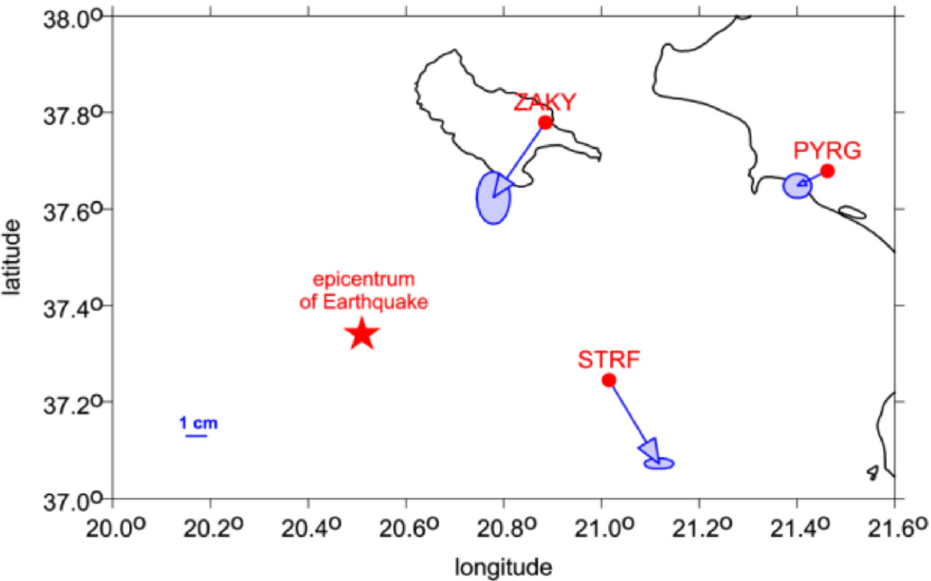
Figure 4. Geographical distribution of stations PYRG, STRF, and ZAKY, associated with a vector of horizontal shift and 2.95 sigma errors (RMSE 2nd approach).